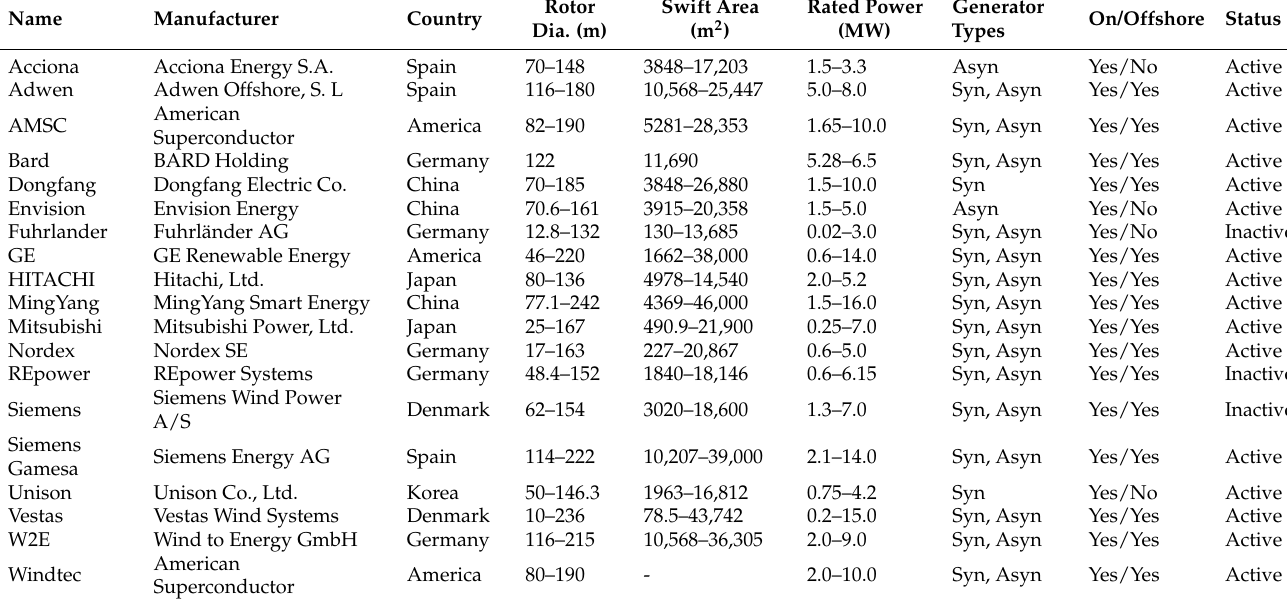
Table 2. Large wind turbine generators in the